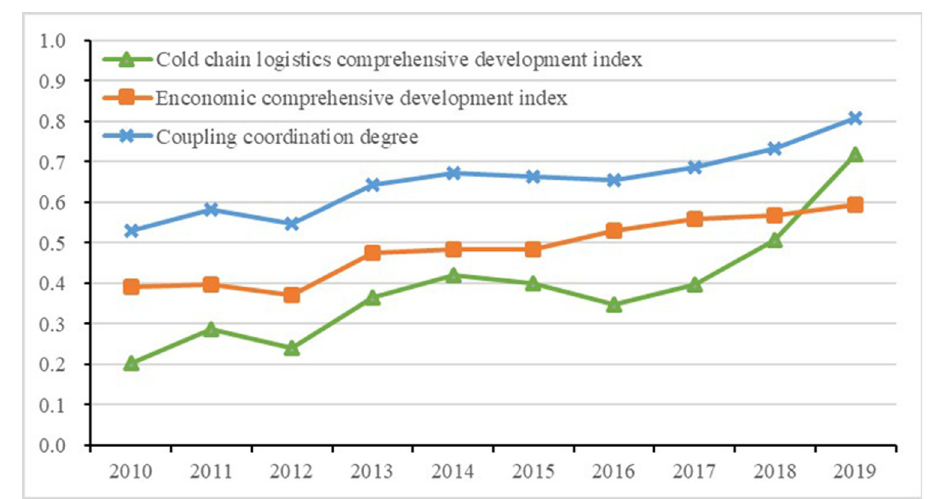
Fig 1. Trend in coupling relationship from 2010 to